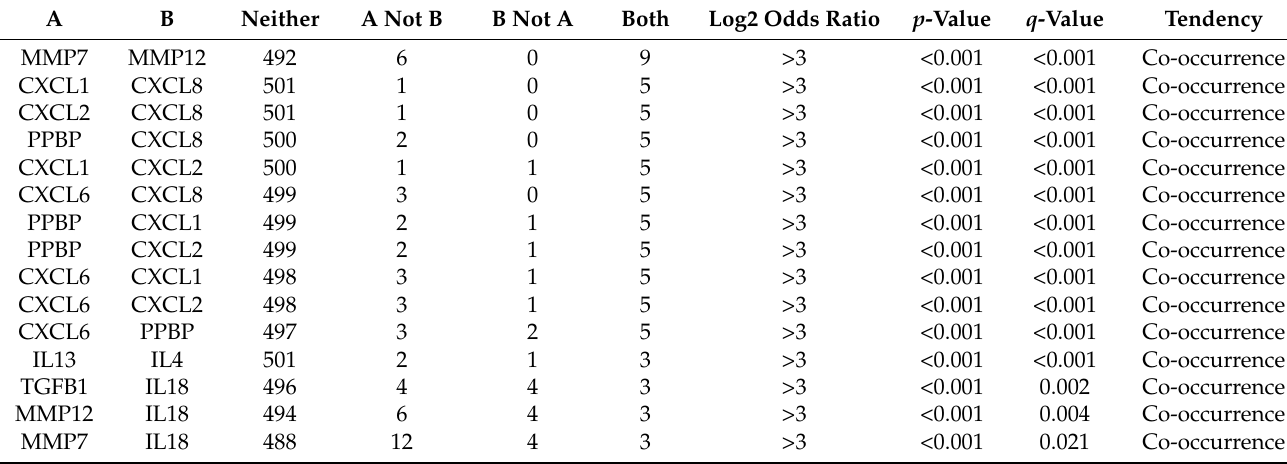
Table 2. Co-occurrence of frequently altered immune genes in the TCGA pan-cancer LUAD dataset ( n = 507). Queried genes ( IFNG , IL10 , IL6 , CD4 , B2M , CD274 , MMP7 , HAVCR2 , PDCD1 , IL17A , CXCR2 , TNF , MMP12 , CXCL6 , NFKB1 , PPBP , CXCR1 , NFKB2 , TGFB1 , IL18 , CTLA4 , CCR2 , CXCL1 , CXCL2 , CXCL8 , IL13 , SPP1 , IL1B , IL4 , CCL2 , CD8A ) were